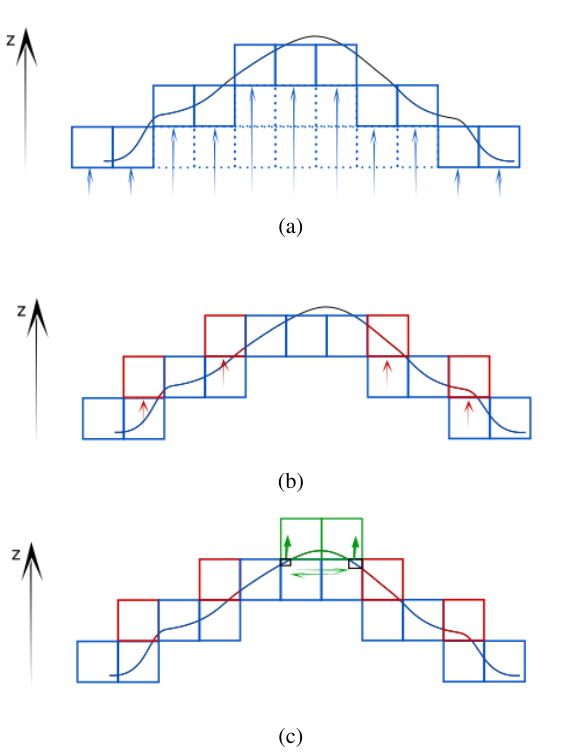
Figure 2. The three steps of the ground detection. (a) first step: The lowest existing voxels to each x-y-coordinate (blue ones) are marked as ground voxels. This can be interpreted as creating sampling points of a continuous ground function (black graph). The blue arrows show the search direction along the z axis and dotted voxels are non existing voxels. (b) second step: adding voxels where at least one neighbour is marked as ground and have higher or equal z-values. (c) third step: Look if there are sub bounding boxes (black) of the ground voxels which don’t touch each other (green arrows). In this case, the next voxles along z are added to the ground (marked in